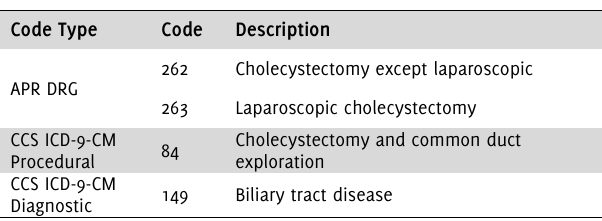
Table 1 . Procedural and Diagnostic Codes Included in Study.